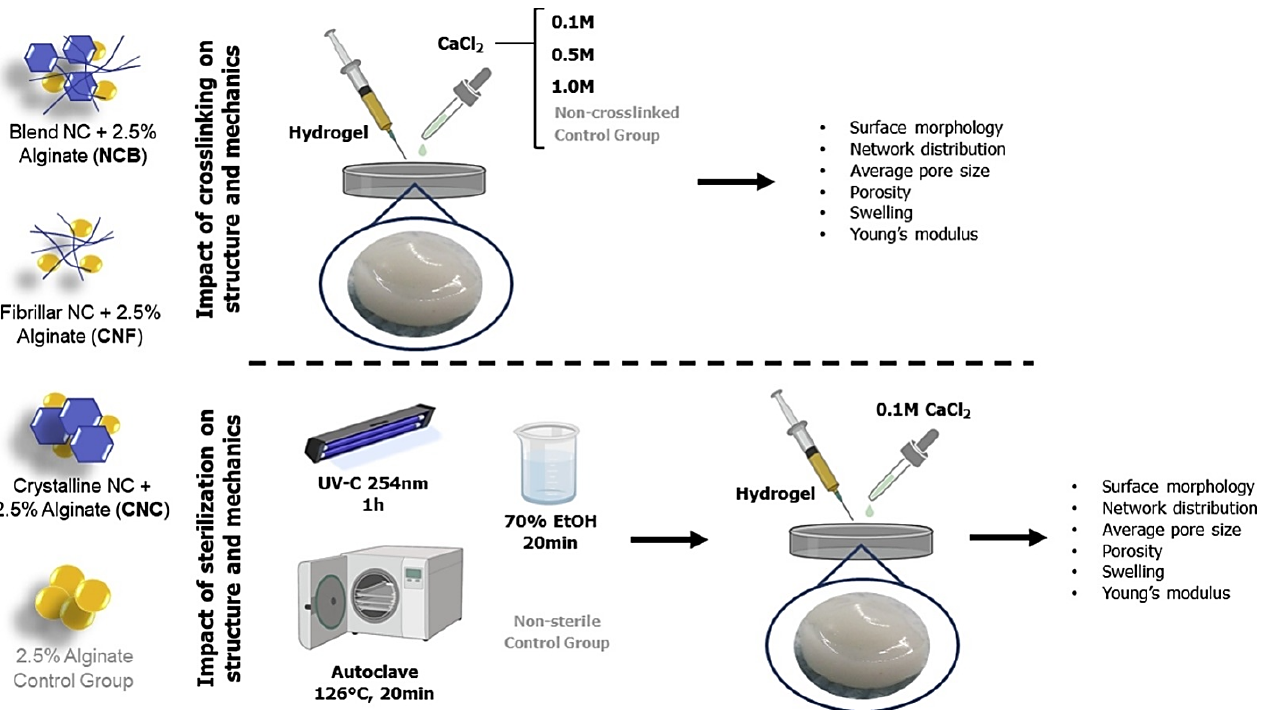
Figure 4. The impact of crosslinking and sterilization on mechanical and structural properties of nanocellulose-based hydrogels for cartilage tissue engineering. NCB: nanocellulose blend; CNC: nanocellulose crystals; CNF: nanocellulose fibrils. Adapted from reference [27] with permission. Copyright 2019 Elsevier.